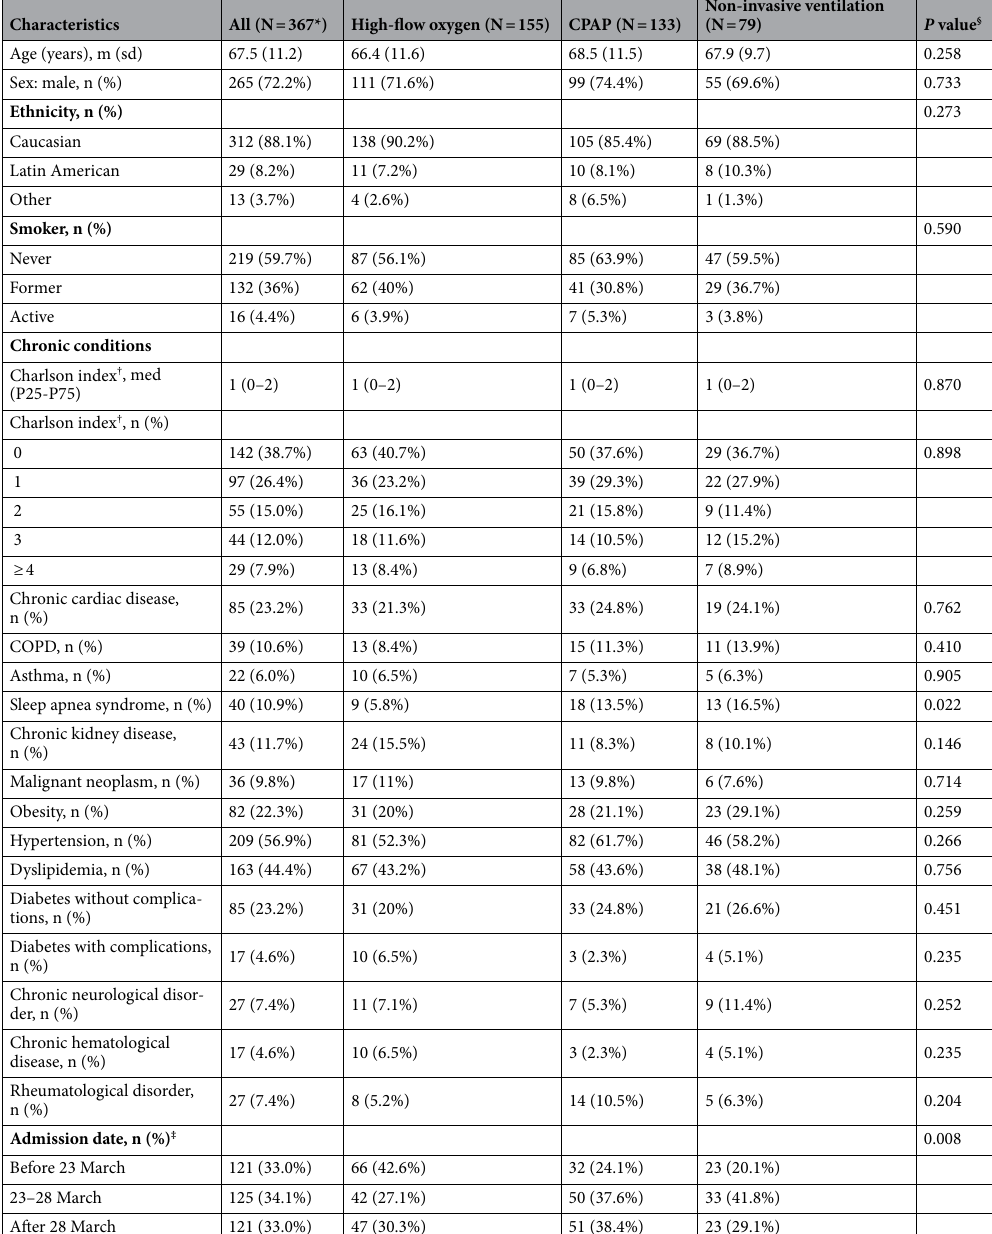
Table 1. Patients’ baseline characteristics, according to non-invasive respiratory support group. *Data on ethnicity were missing in 13 cases. † Modified Charlson comorbidity Index 24 . ‡ Date of admission was categorized in three groups approximating tertiles. § Chi 2 test or Fisher exact test (when a cell included < 5